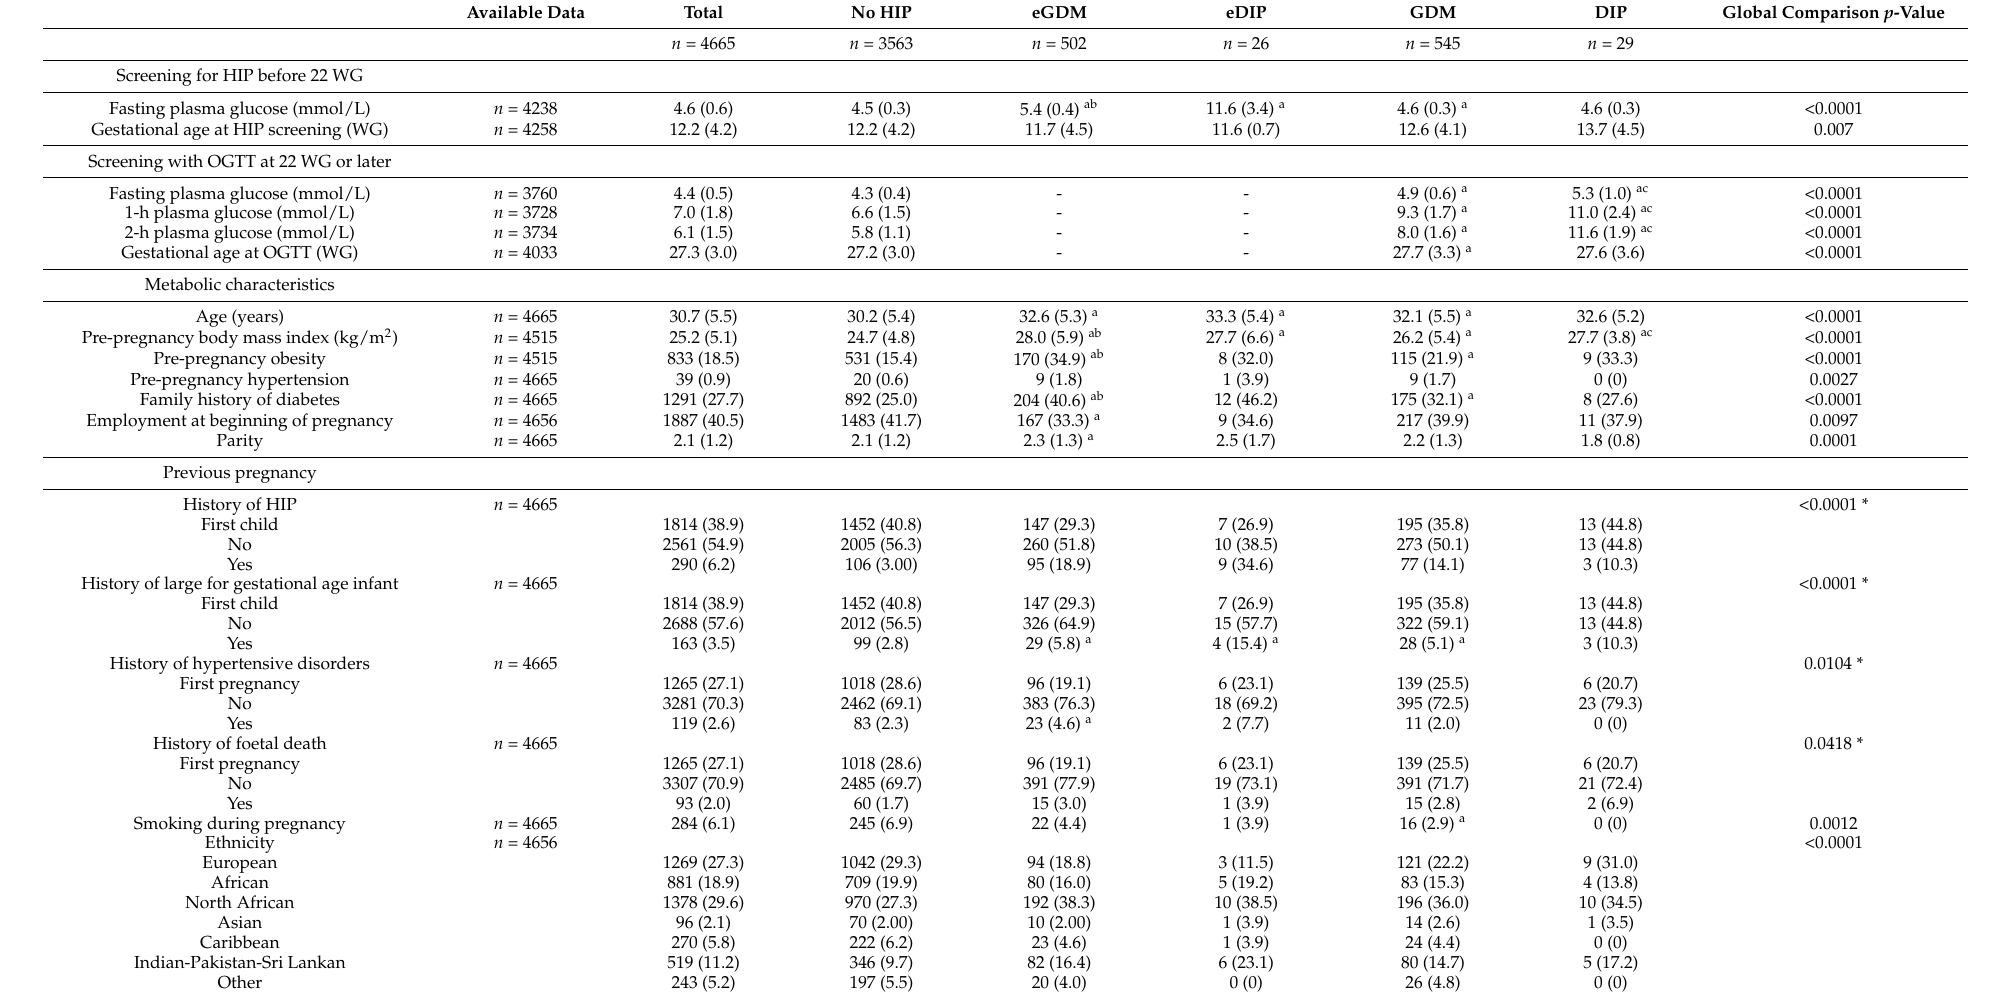
Table 1. Characteristics and pregnancy outcomes according to glycaemic